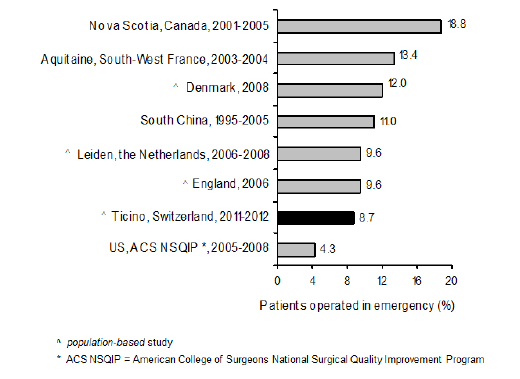
Figure 1: QI6. Proportion of patients with colorectal cancer under- going emergency surgery: comparison between southern Switzer- land and other